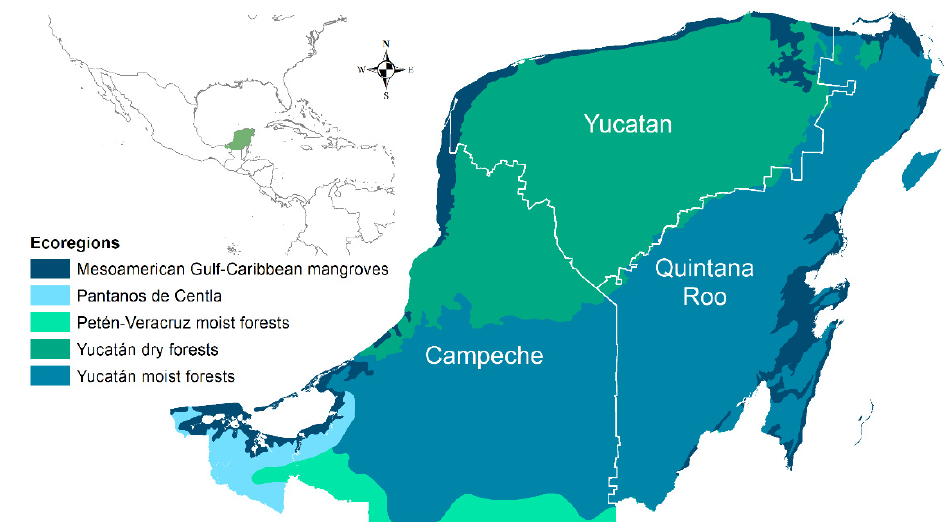
Figure 1. Mexican portion of the Yucatan Peninsula with ecoregions. White lines stand for adminis- trative states.